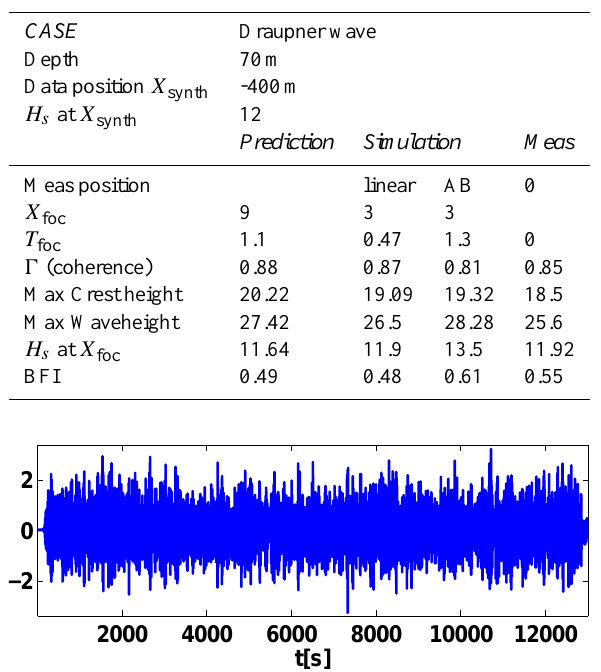
Table 2. Parameters for the Draupner wave.